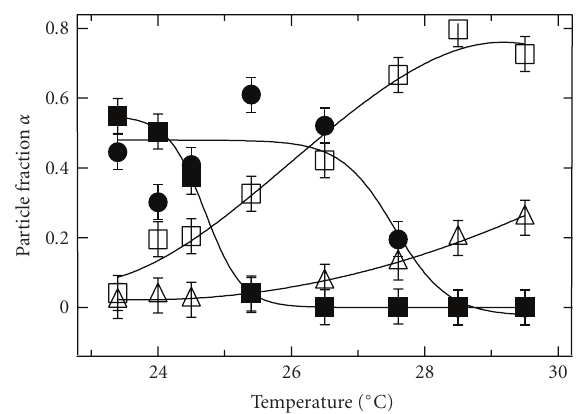
Figure 4: Fitting results. Temperature dependence of the fraction of particles assembled in di ff erent forms. Symbols are as in Figure